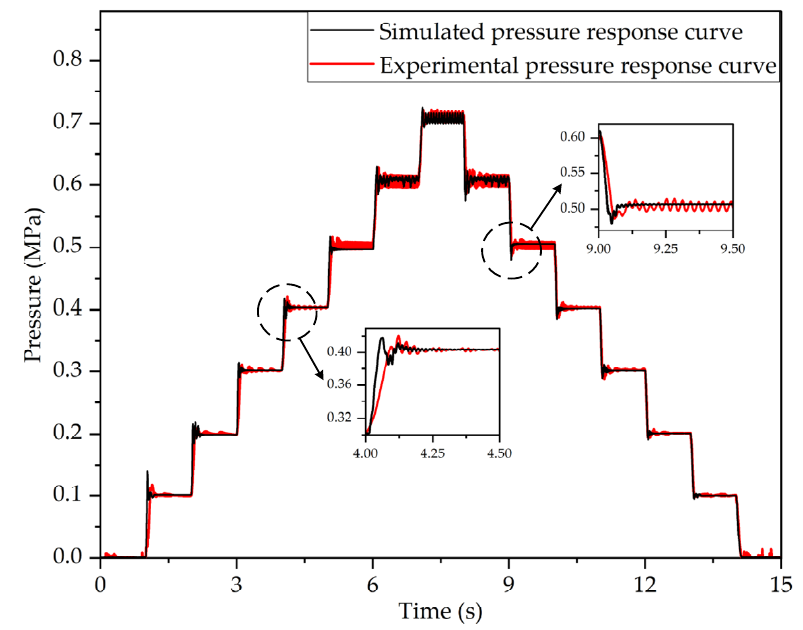
Figure 10. The outlet pressure response characteristics curves of the LF-APRV under continuous graded braking conditions obtained by test and simulation.